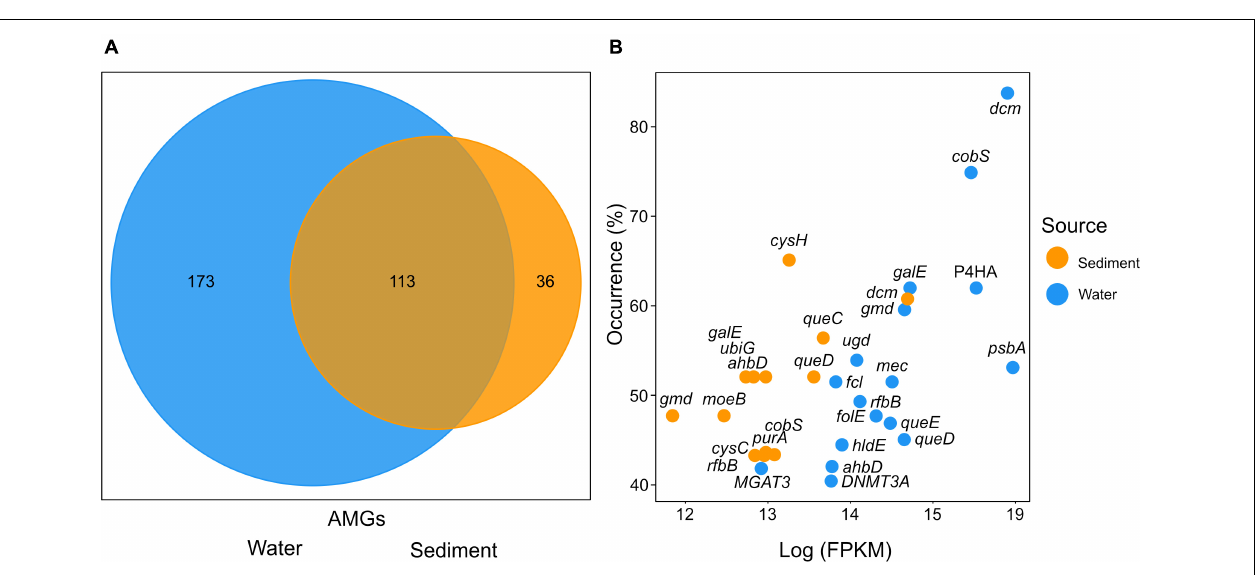
FIGURE 5 | (A) Number of unique KEGG orthologs specific to either water or sediment viral composition. The overlap displays the number of unique KEGG orthologs found in both sediments and the water column. (B) The distribution of the most abundant KEGG orthologs plotted by station occurrence over Fragments Per Kilobase per Million reads (FPKM) assigned. The x-axis displays the log FPKM count of KEGG orthologs. The y -axis indicates the occurrence in stations (%) of samples in which the KEGG orthologs were found calculated per source. The cutoff was chosen at 40% of stations. Colors indicate the gene